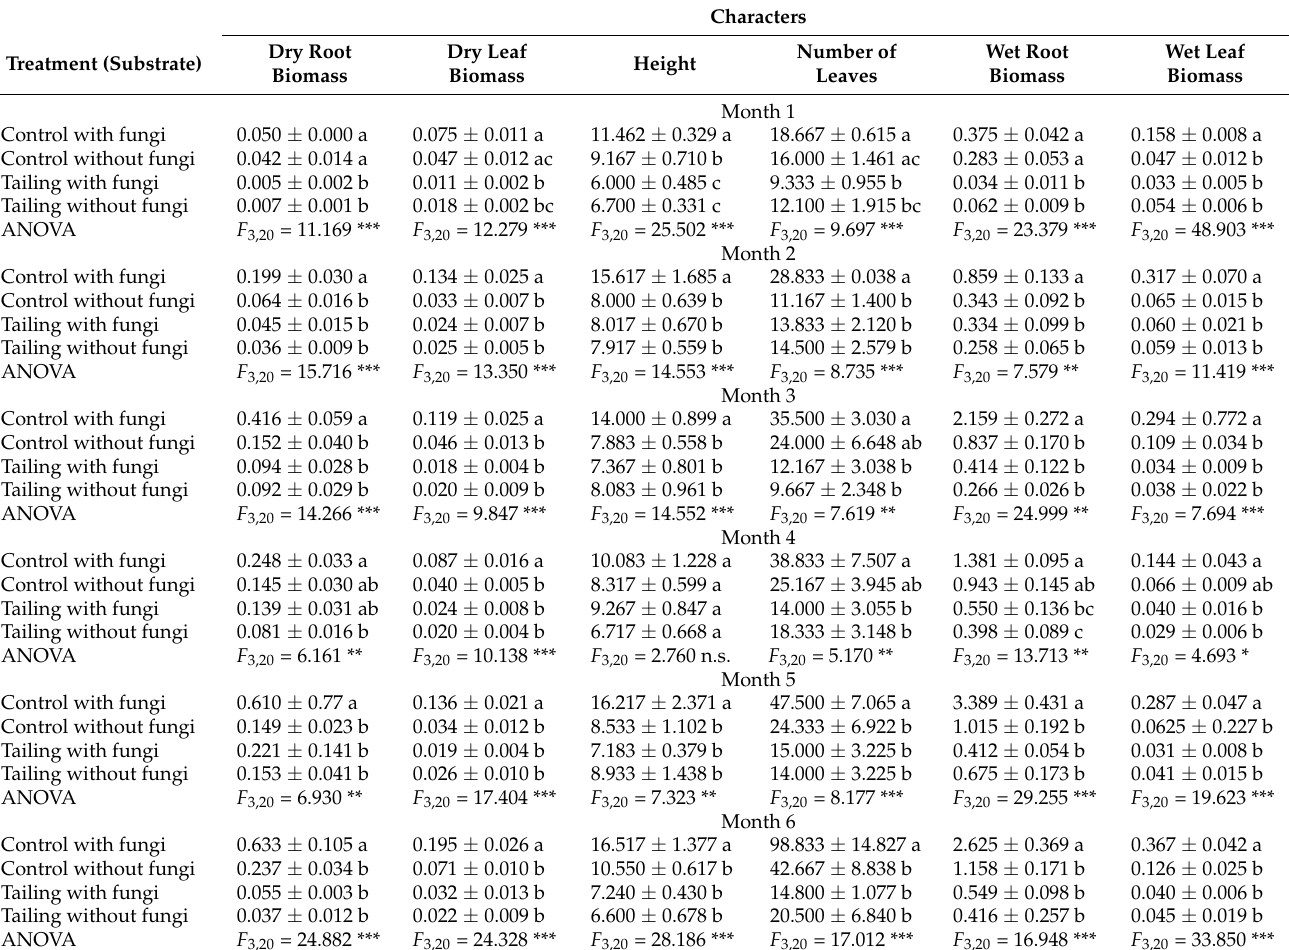
Table 4. Average values ± standard error and one-way ANOVA results to evaluate the effect of treatment (control with fungi, control without fungi, tailing with fungi and tailing without fungi) on size characters of Prosopis laevigata growing under greenhouse conditions. Different letters show significant differences in individuals growing under different treatments (Tukey p < 0.05). * p < 0.05, ** p < 0.01, *** p < 0.001, n.s. = not significant